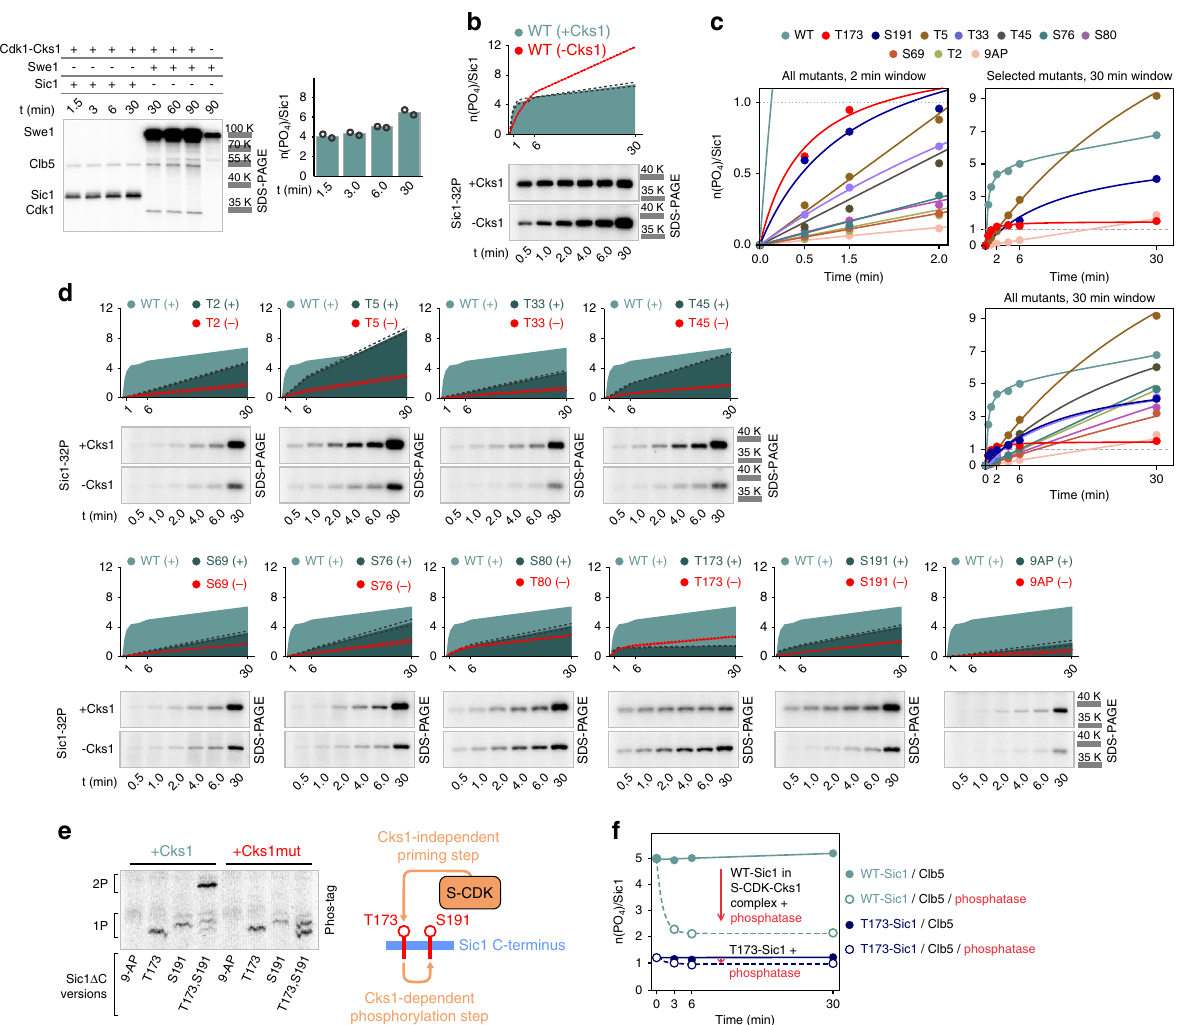
Fig. 3 The phosphorylation site-speci fi city is lost within the inhibitory complex. a The stoichiometry of intracomplex phosphorylation of Sic1 in vitro was determined by using inhibitory tyrosine kinase Swe1. Mono-phosphorylation of Y19-Cdk1 by Swe1 was used as a quantitative reference to estimate the number of phosphates added per molecule of Sic1 in a separate S-CDK (Clb5 – Cdk1 – Cks1) kinase assay loaded on the same gel. Bars represent the mean level derived from the data of two values that are obtained from two independent experiments. The values are plotted individually by the open circles. b The stoichiometry for intracomplex phosphorylation of Sic1 in the presence or absence of Cks1 in the assay mixture. The dotted lines represent standard deviation of the time-course obtained from two independent experiments. c Plots demonstrating the Clb5 – Cdk1 – Cks1 – Sic1 intracomplex phosphorylation dynamics of Sic1 versions containing only selected CDK sites with the rest of the CDK sites mutated to alanines. The plots obtained from two independent experiments were nearly overlapping. d The individual phosphorylation pro fi les shown on c plotted together with the wild-type Sic1 phosphorylation pro fi le for comparison. The 9AP denotes the version with all CDK sites mutated to alanines. The dotted lines represent standard deviation of the time-course obtained from two independent experiments. The full Sic1 amino acid sequences can be found in Source data fi le. e In vitro phosphorylation of Sic1 Δ C versions containing the indicated CDK sites with the rest of the CDK sites mutated to alanines to demonstrate the Cks1-mediated double-phosphorylation of diversionary sites using Clb5 – Cdk1 – Cks1 complex. Autoradiographs of Phos-tag SDS – PAGE are shown. f Plot demonstrating the dephosphorylation of Sic1 within Sic1 – Clb5 – Cdk1 – Cks1 complex by lambda phosphatase. The plotted trendlines were obtained by fi tting the data points as described in the Methods section. The plots obtained from two independent experiments were overlapping. The experiments for a – f were performed twice with similar result. The full gel radiographs are presented in Supplementary Fig. 7. Source data are provided as a Source Data fi